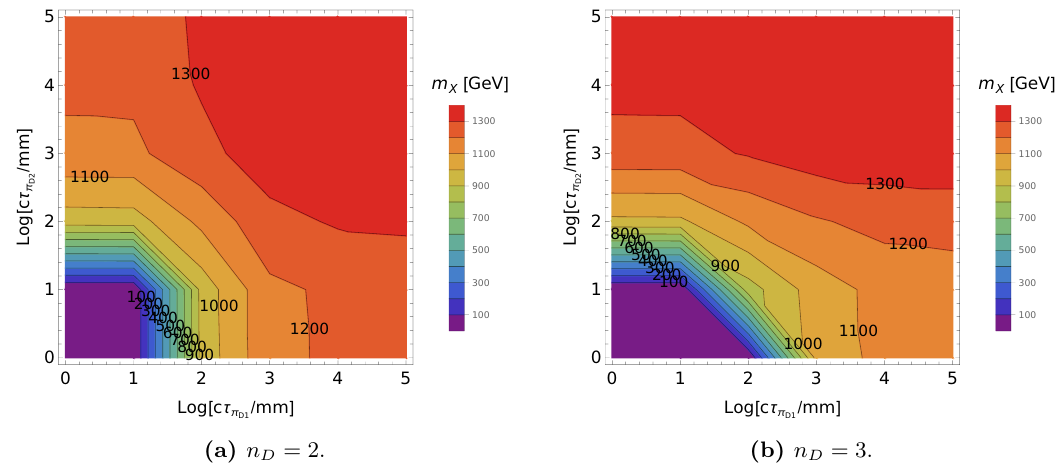
Figure 7. Constraints on the mediator mass for two (left) and three (right) dark flavours from the MET search with cτ π : diagonal dark pion decay length, cτ π : off-diagonal dark pion decay D1 D2 length. Values with m X smaller than the one displayed by the contour lines are excluded.